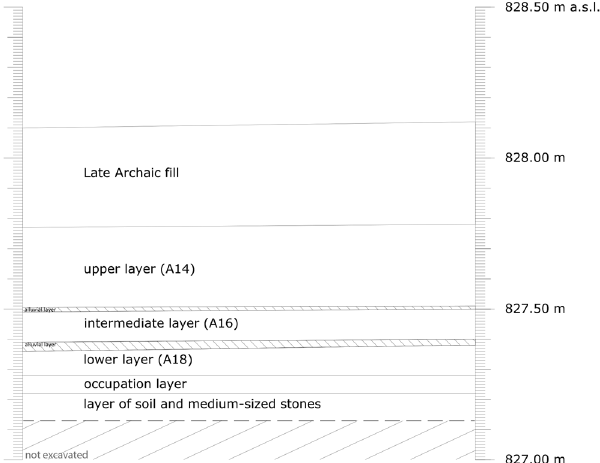
Figure 6. Schematic representation of the excavated area at the archaeological Monte Iato settlement showing the studied layers A14 (upper), A16 (intermediate) and A18